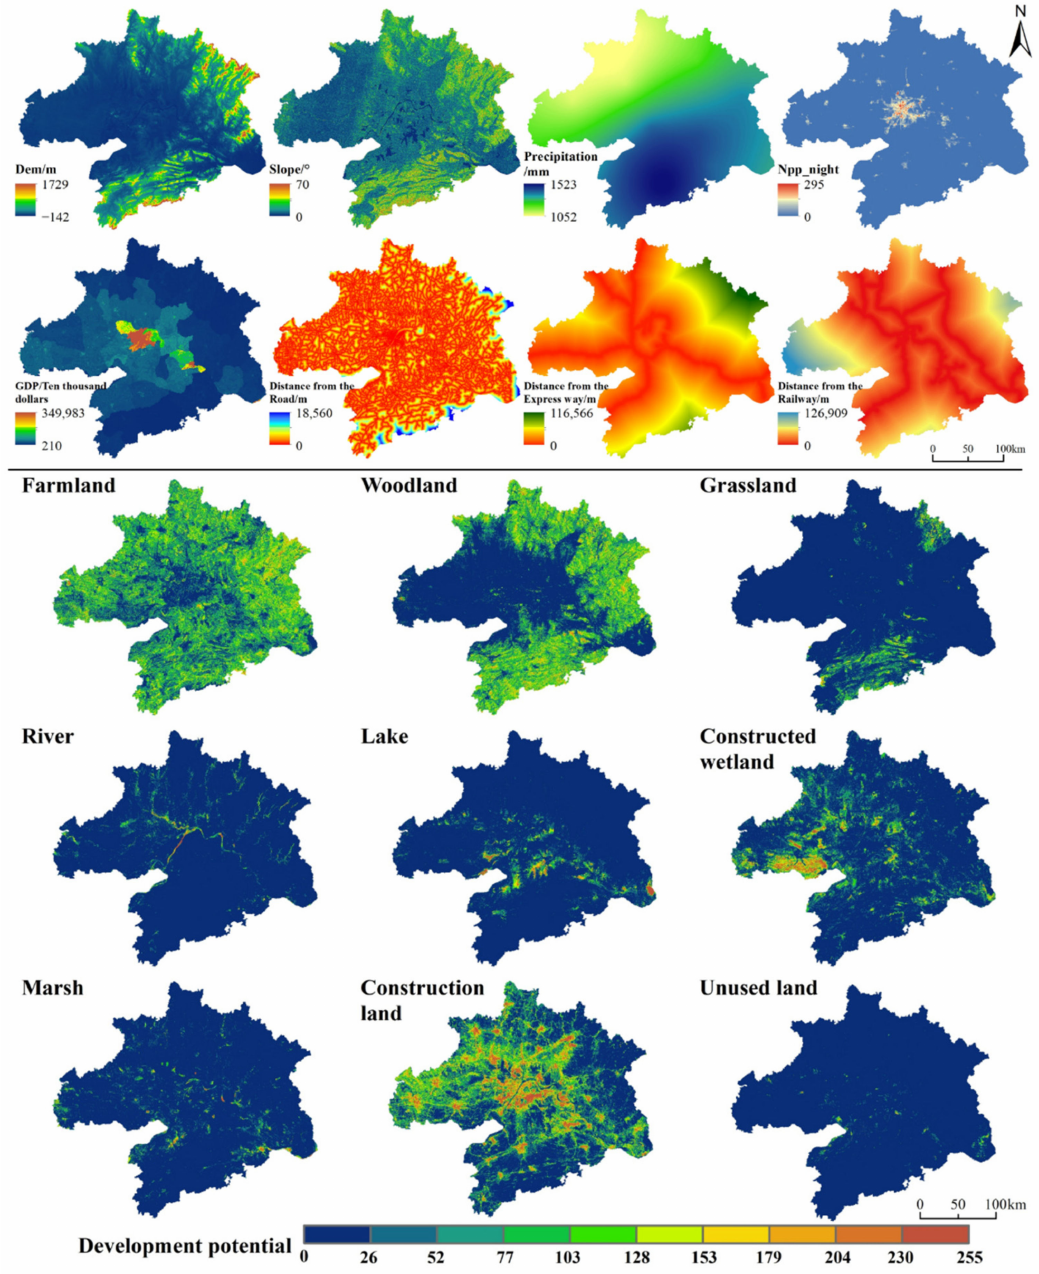
Figure 3. Driving factors for calculating the different land-use probabilities of occurrence in